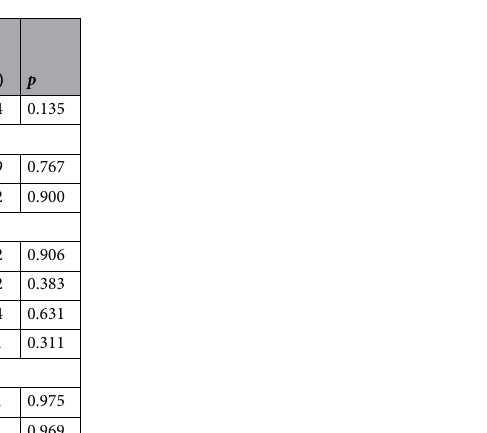
Figure 5. Example of eye movement traces and average pursuit gain. ( A ) Shows the horizontal and vertical vehicle trajectory and unprocessed eye movement traces of one participant in degrees of visual angle. The solid black line denotes the visible vehicle trajectory. The dotted black line denotes the extrapolated vehicle trajectory (assuming constant velocity) after the vehicle disappeared. Saccades are marked in red. ( B ) Shows pursuit gain averaged over participants ( N = 14) and trials. Shaded areas indicate standard errors of the sample means. The 2–3 s time interval before the car disappeared was used as the averaging interval for pursuit gain, relative and absolute position deviations.